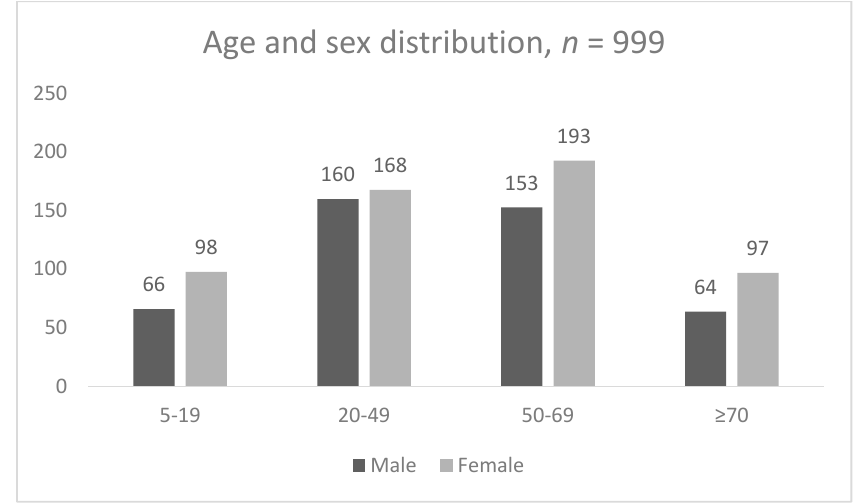
Figure 1. Age and sex distribution of participating patients.